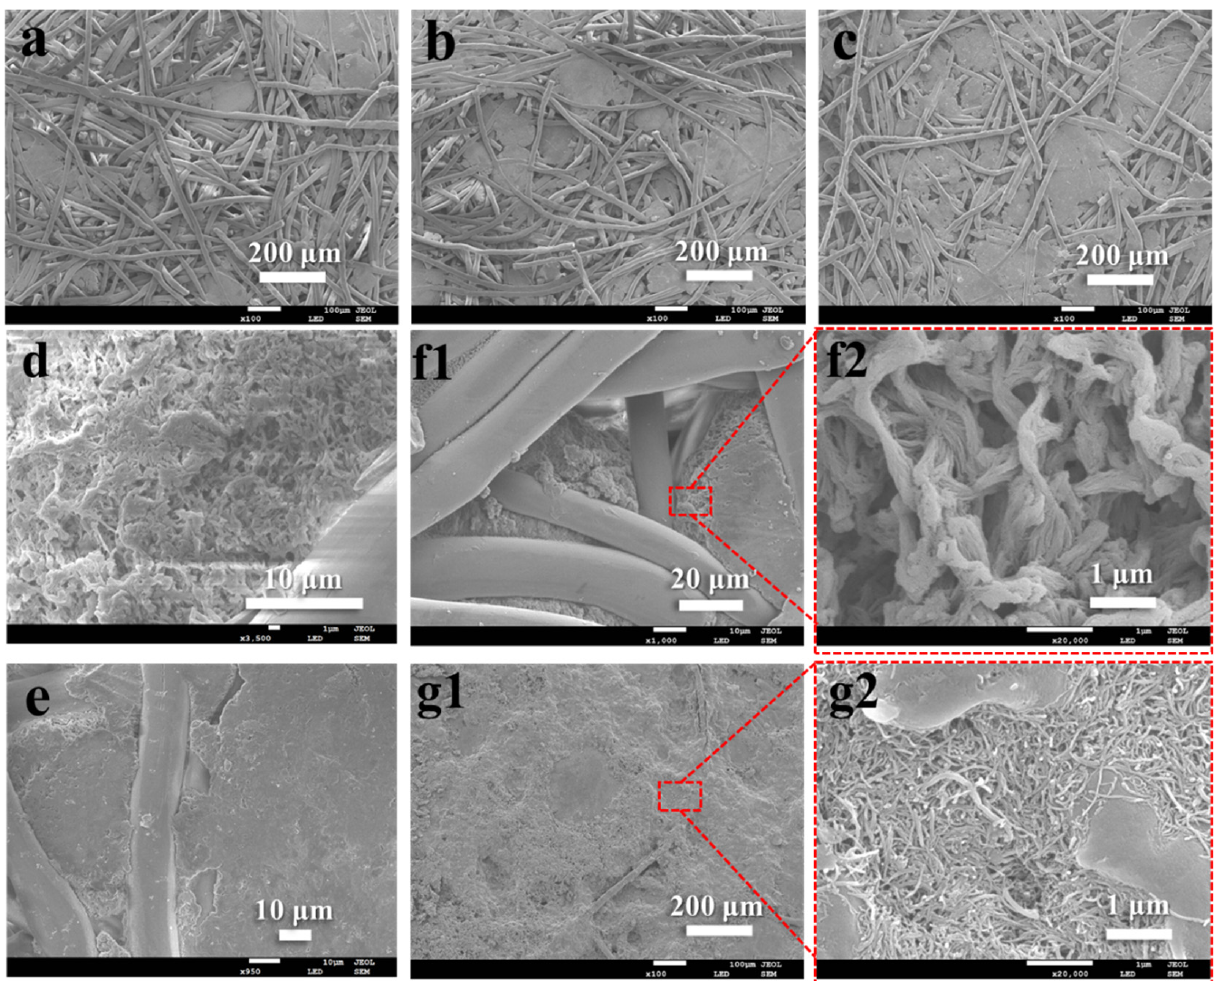
Figure 3. SEM images of PPS papers with weight ratio of PPS chopped fiber and PPS solid solution powder at ( a ) 1:2, ( b , d , e , f ) 1:3, ( c ) 1:4 and ( g ) top surface of MWCNTs@HPPS paper. 1 and 2 represent low and high magnification, respectively.